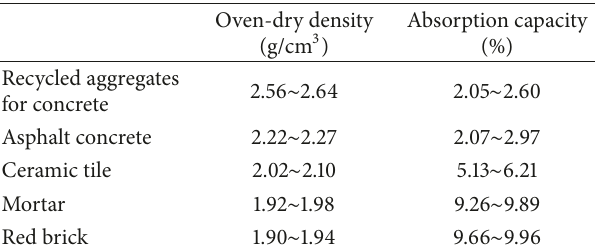
Table 2: Summary of oven-dry density and absorption capacity of typical materials in mixed CDW recycled aggregates produced by recycling plants in